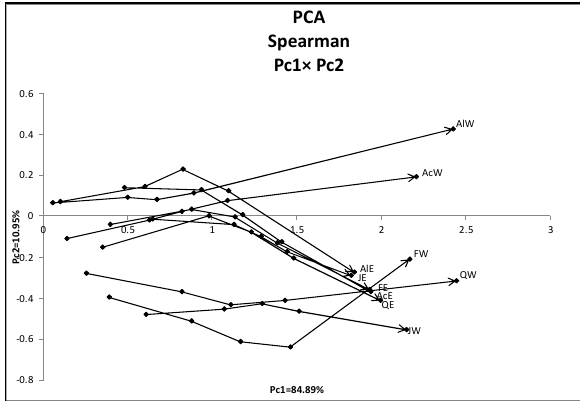
Figure 16. PCA result for hardwood data.